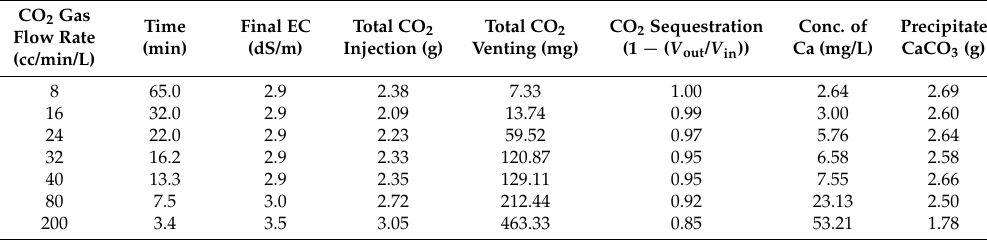
Table 3. Overall results of carbon mineralization processes with changes in CO 2 gas flow rates (2.5 L of solution).